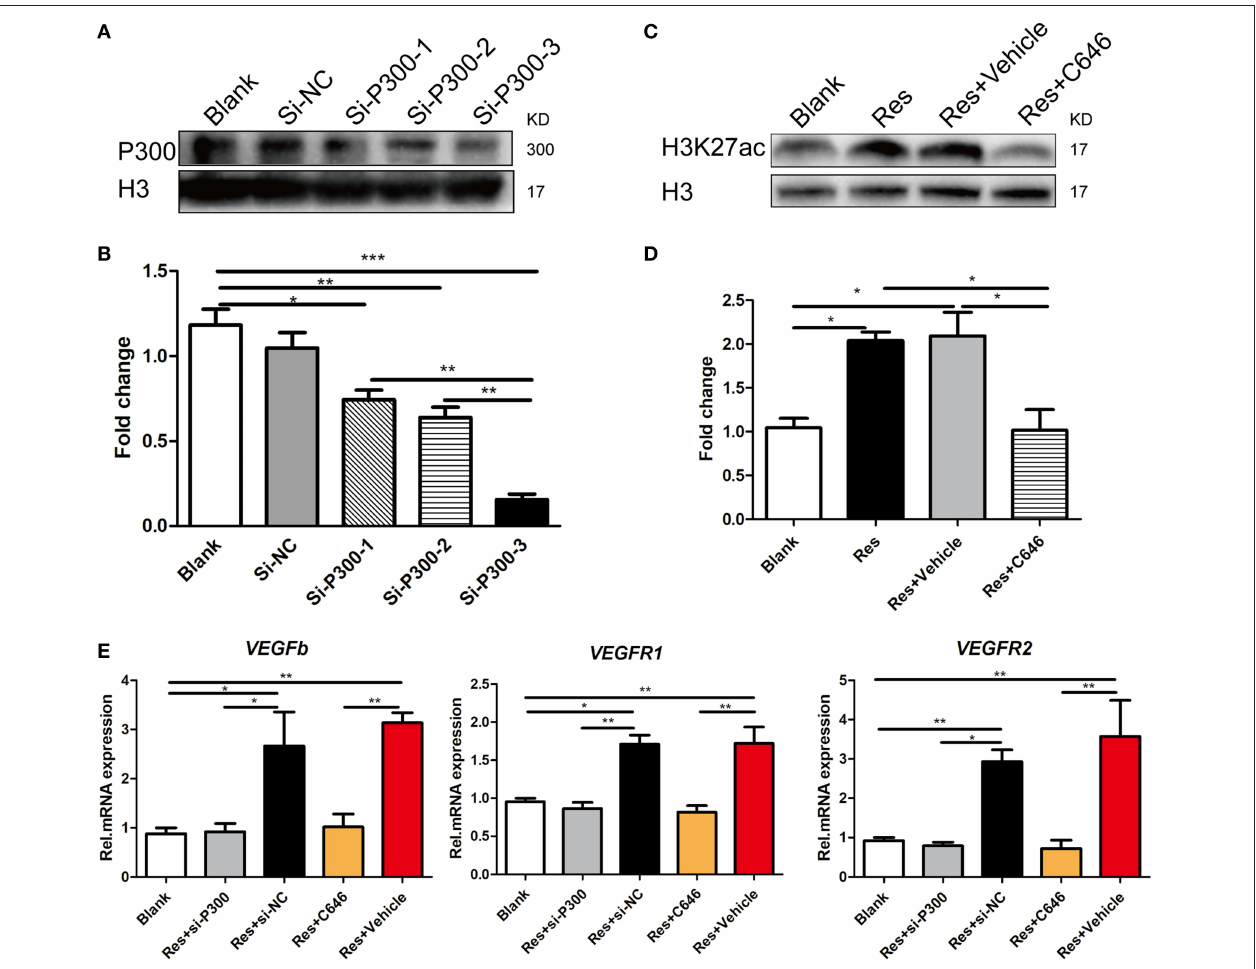
FIGURE 4 | p300 knockdown and the inhibition of p300 acetyltransferase activity separately suppressed the Res-induced expression of VEGFs in differentiated PC-12 cells. (A,B) The protein expression of p300 in differentiated PC-12 cells was inhibited by the transfection of three p300-targeting siRNAs. Among these three siRNAs, si-P300-3 showed the highest efficiency of p300 knockdown (* P < 0.05, ** P < 0.01 , *** P < 0.01 ). (C,D) Resveratrol (Res) enhanced the expression of H3K27ac, but C646, an inhibitor of p300 acetyltransferase activity, reversed the increase in H3K27ac induced by Res in differentiated PC-12 cells (* P < 0.05 ). (E) si-P300-3